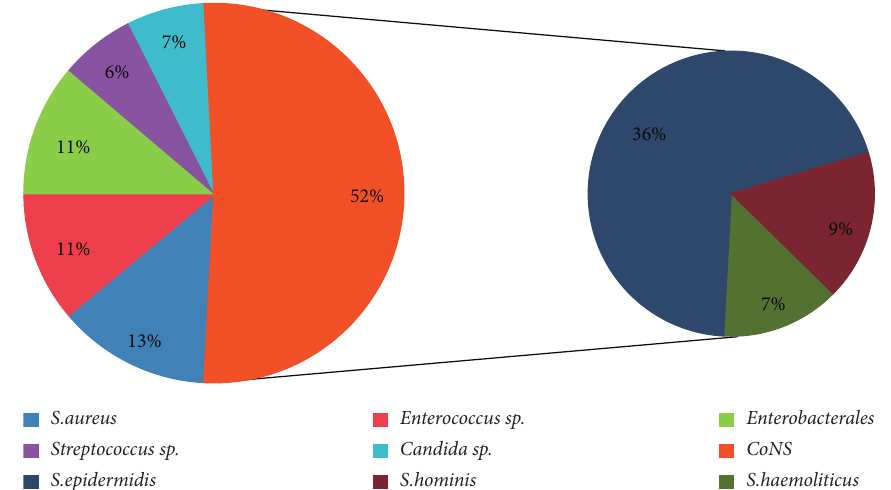
Figure 2: The causative agents of sepsis in